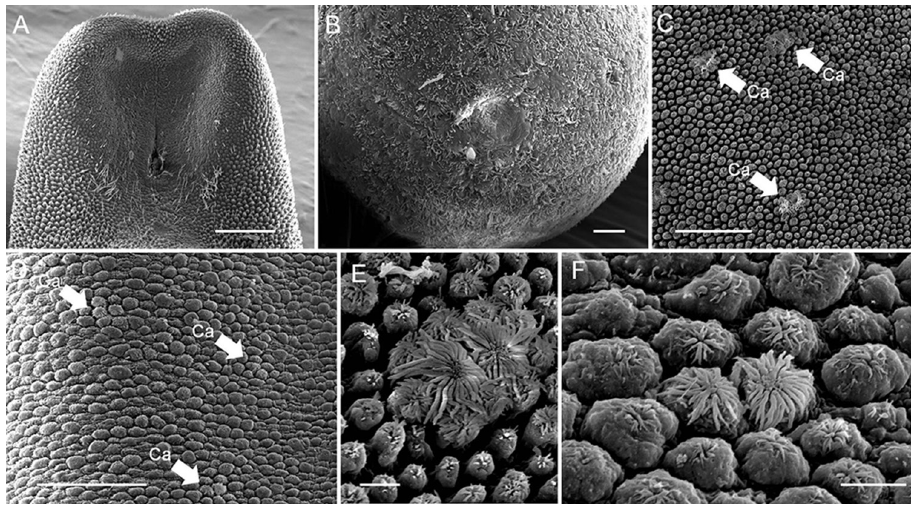
Figure 8. Male adult Chordodes formosanus from novel hosts. A Posterior end B Anterior end C–D Vari- able crowned areole morphologies from different individuals E Close view of ( C ) with typical C. formosa- nus crowned areoles; F Close view of ( D ) with smaller crowned areoles. Ca, crowned areole. Scale bars 100 µm ( A ), 10 µm ( B ), 100 µm ( C–D ), and 10 µm ( E–F